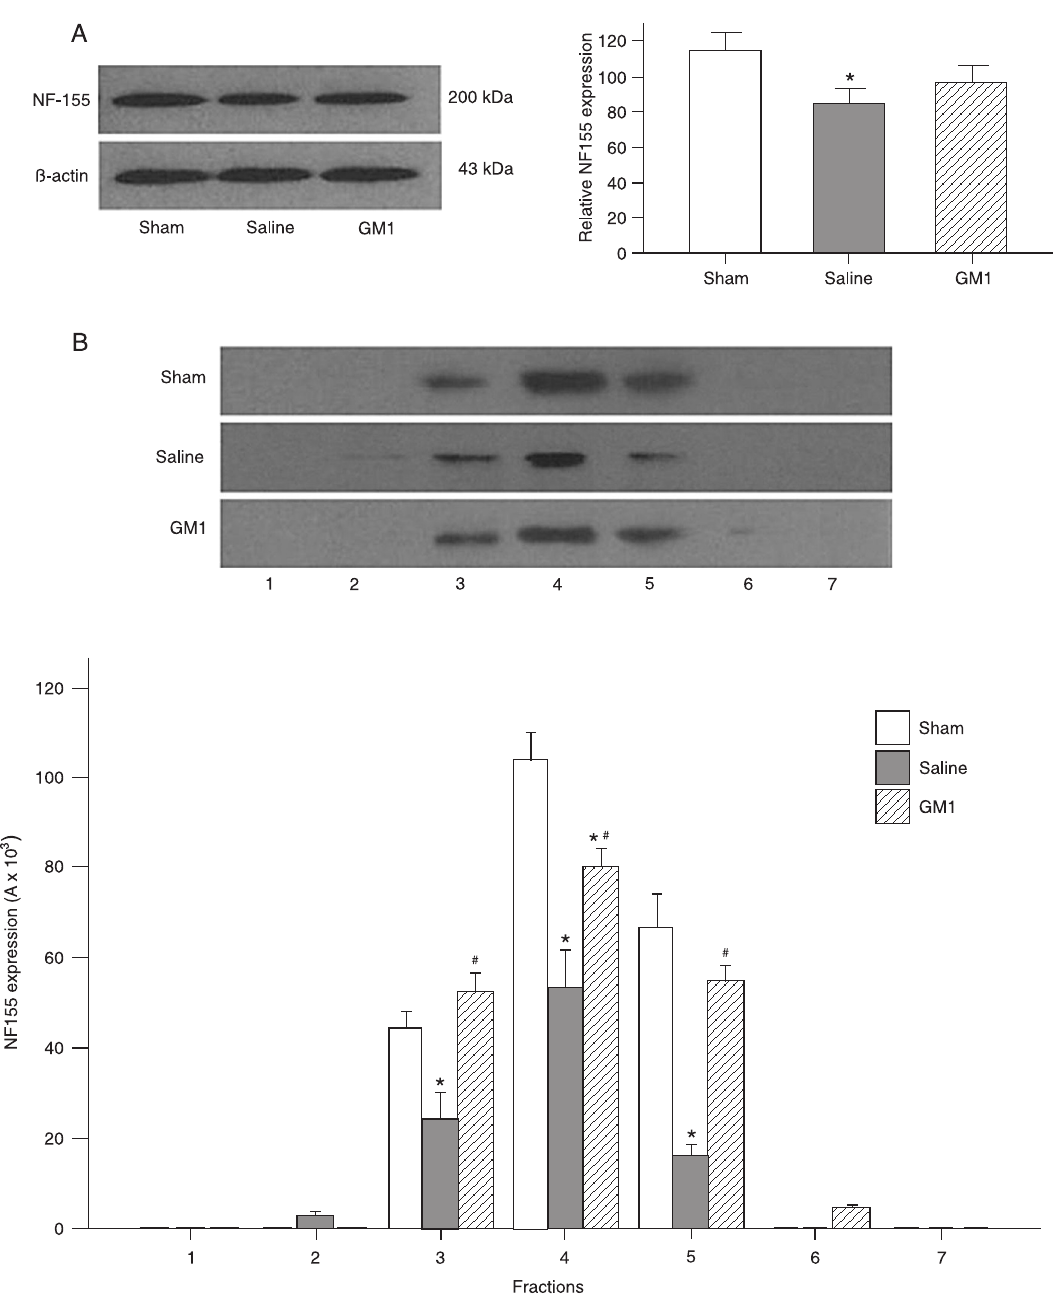
Figure 3. Western blot analysis of neurofascin 155 (NF155) expression in the brain tissue and lipid rafts of rat left cerebral hemispheres from each group at postpartum day 30 (P30). A , NF-155 was present as a 200-kDa band in the lanes, which corresponded to a higher molecular mass than expected due to glycosylation. The bar graph on the right shows that NF155 content was significantly lower in the Saline group compared to the Sham group and was higher in the GM1 group injected with monosialotetrahexosyl ganglioside (GM1) than in the Saline group. Relative expression was calculated by normalization of the absorbance (A) of NF155/A to that of control (β-actin). B , Western blot analysis of NF155 in lipid rafts showed that the NF155 content of the Saline group was significantly lower than in the Sham group and was higher in the GM1 group than in the Saline group. Lanes 1-7 in the Western blot show the bands of NF155 in 7 fractions prepared by OptiPrep gradient centrifugation. *P < 0.05 vs Sham group; # P < 0.05 vs saline group (one-way analysis of variance (ANOVA) with Bonferroni’s corrections in post hoc